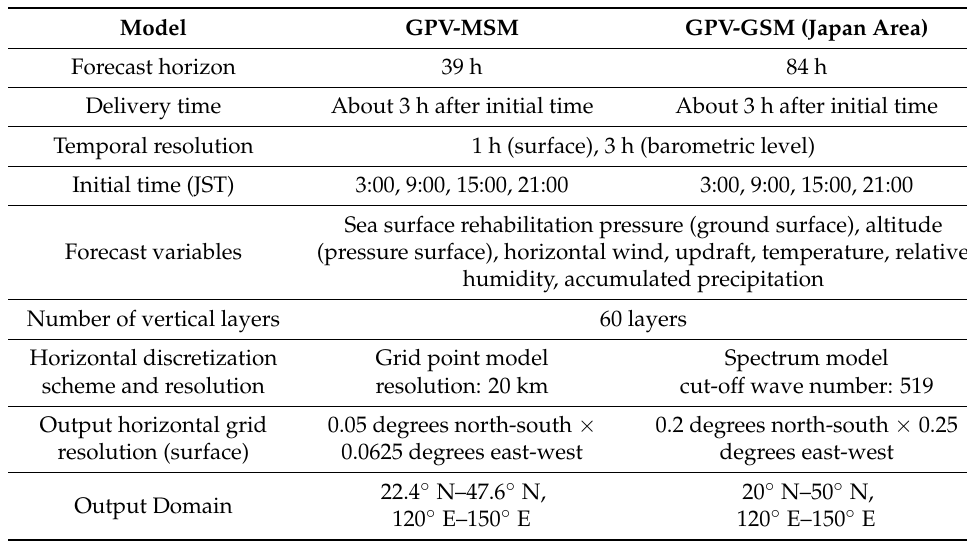
Figure 1. Overview of the proposed model. Table 1. Summary of numerical weather prediction data used in this